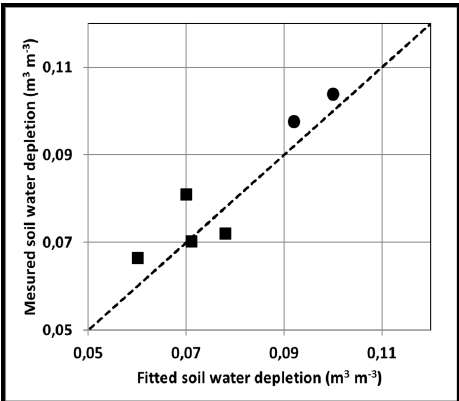
Figure 3. Comparison between fitted (X-axis) and measured (Y-axis) soil water depletion in the two experimental sites and for all irrigations used during the fitting process. The continuous line is the 1:1 line, black squares are for the first site, black circles are for the second site.